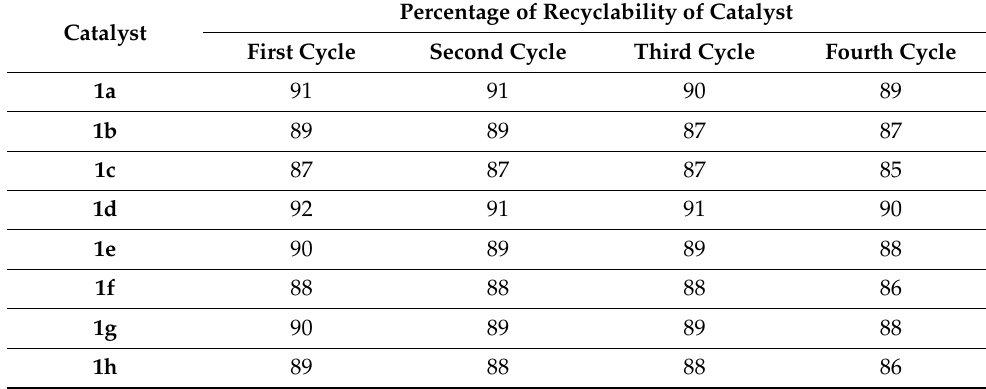
Table 6. Reusability of catalysts 1a – 1h .